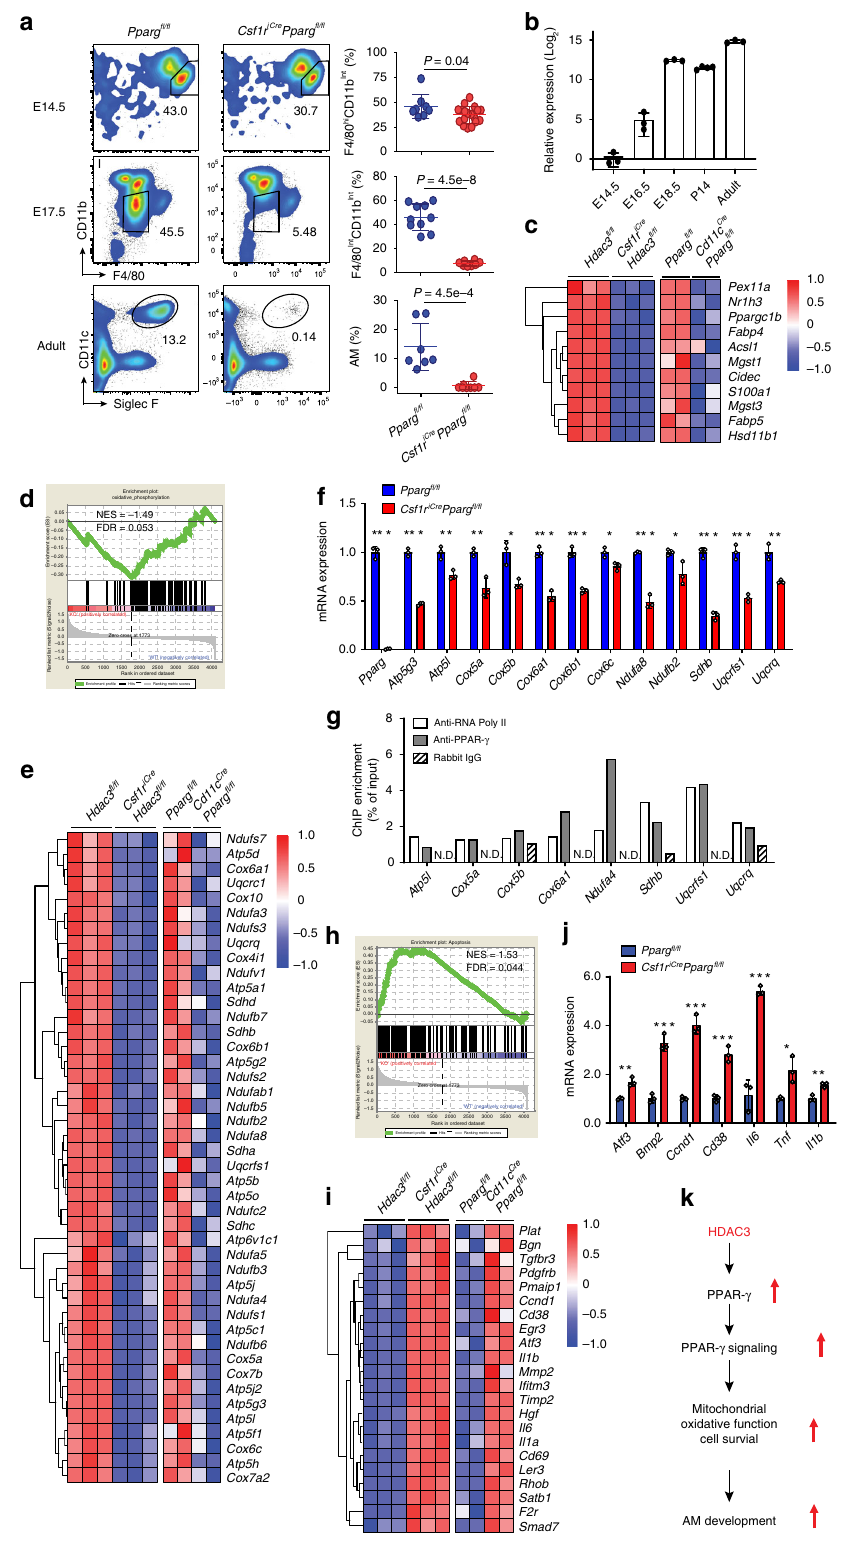
Enrichment plot: